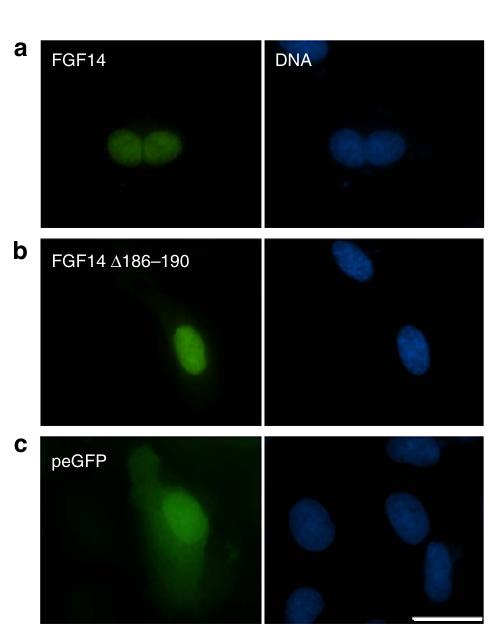
Figure 4 | Localization of the GFP-FGF14 fusion proteins in transiently transfected U2OS cells. ( a ) wildtype ( b ) mutant ( c ) control GFP. Green- fusion proteins, blue- Hoechst stain. Scale bar, 20 m